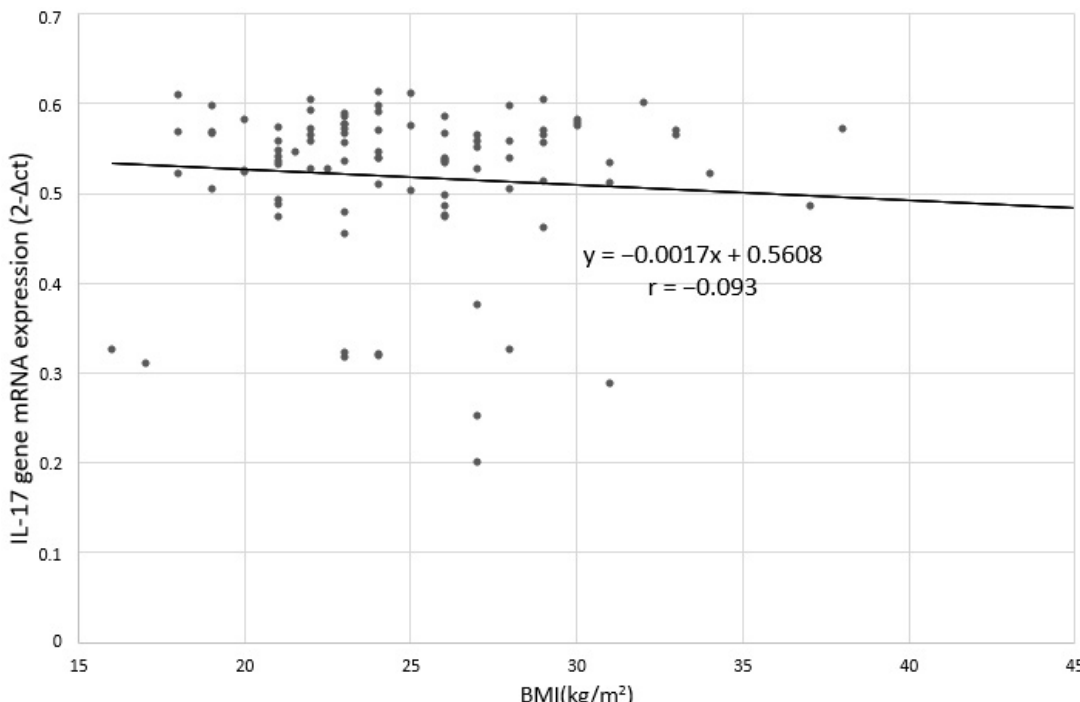
Figure 5. Correlation between IL-17 gene mRNA expression and BMI in depressed patients .; r: Pearson’s linear correlation coefficient.